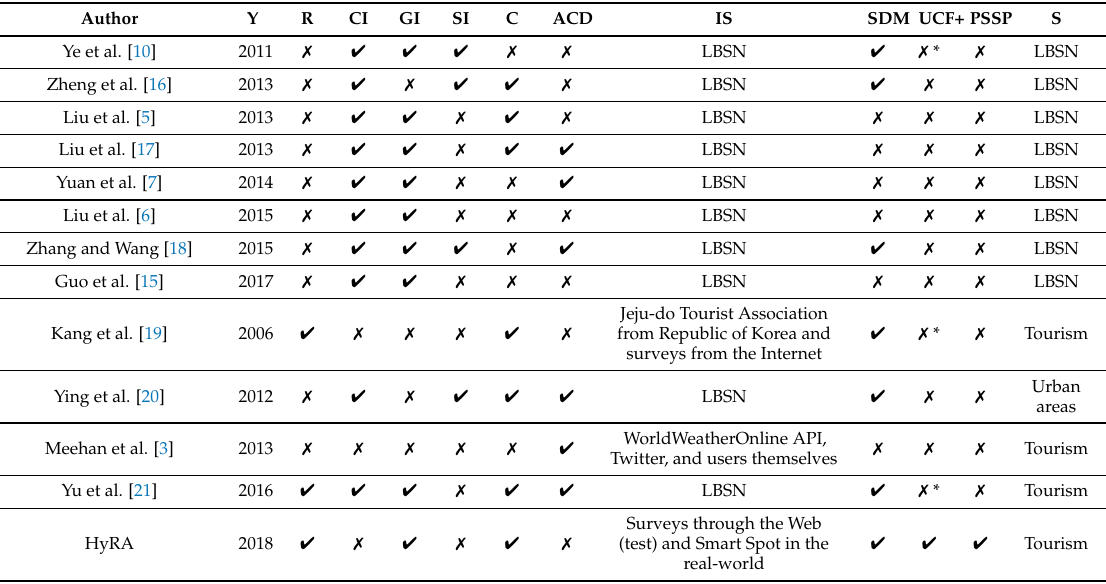
Table 1. Comparison of the POI recommendation